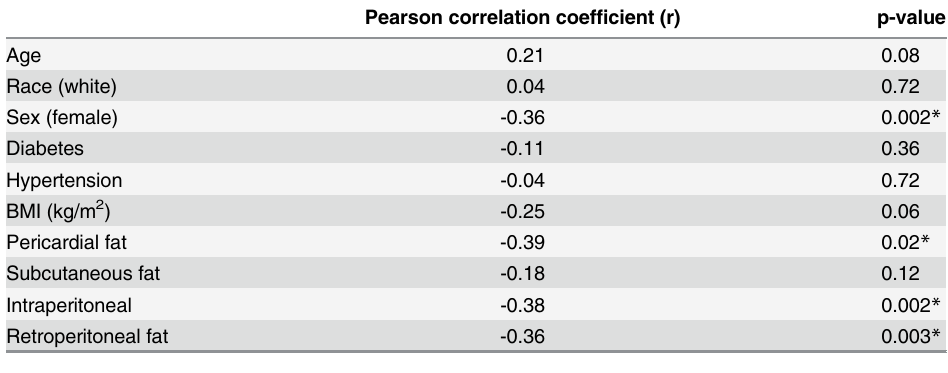
Table 3. Correlations between covariates and myocardial perfusion index at peak dose dobutamine in both men and